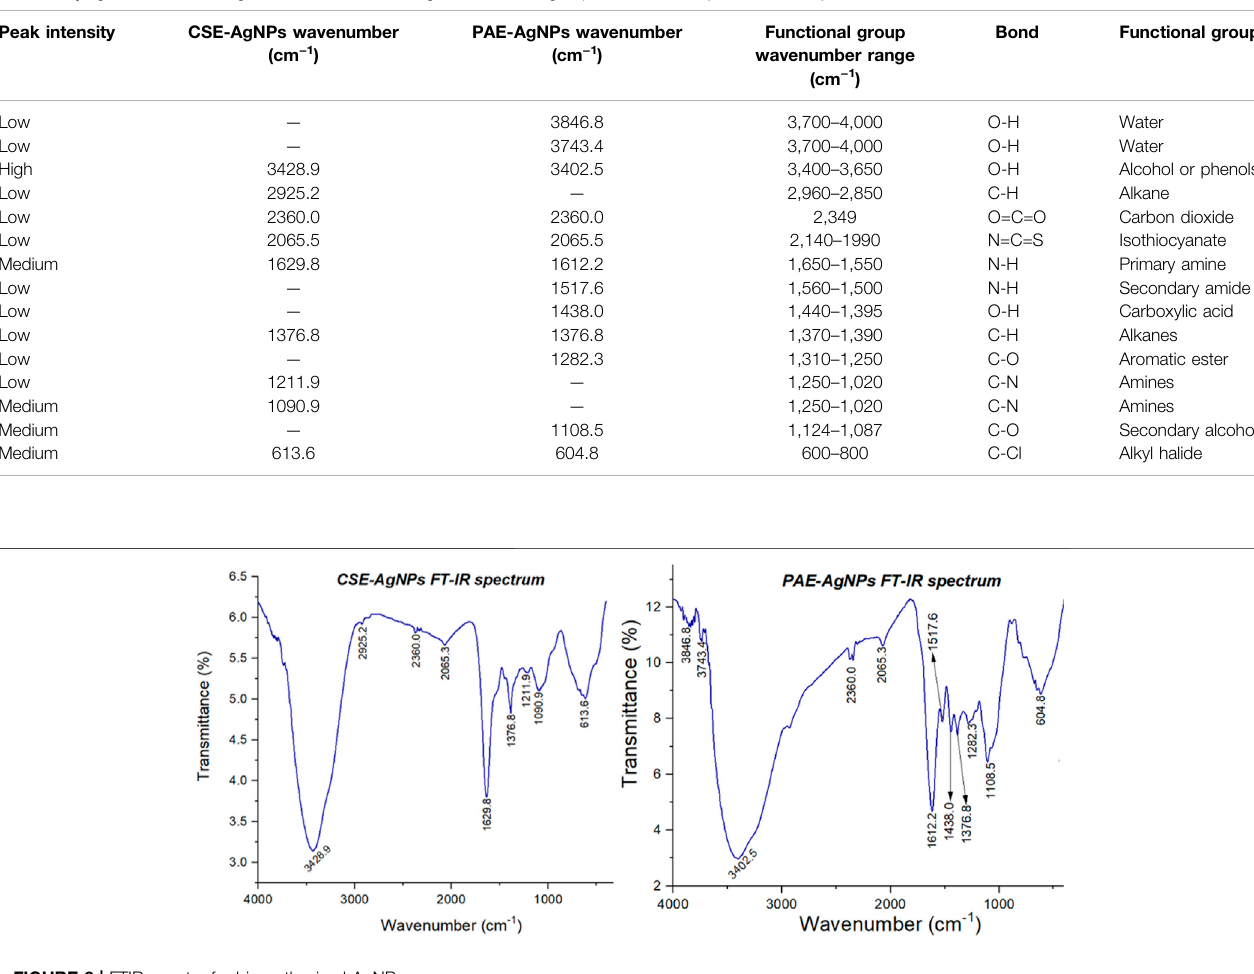
FIGURE 8 | FTIR spectra for biosynthesized